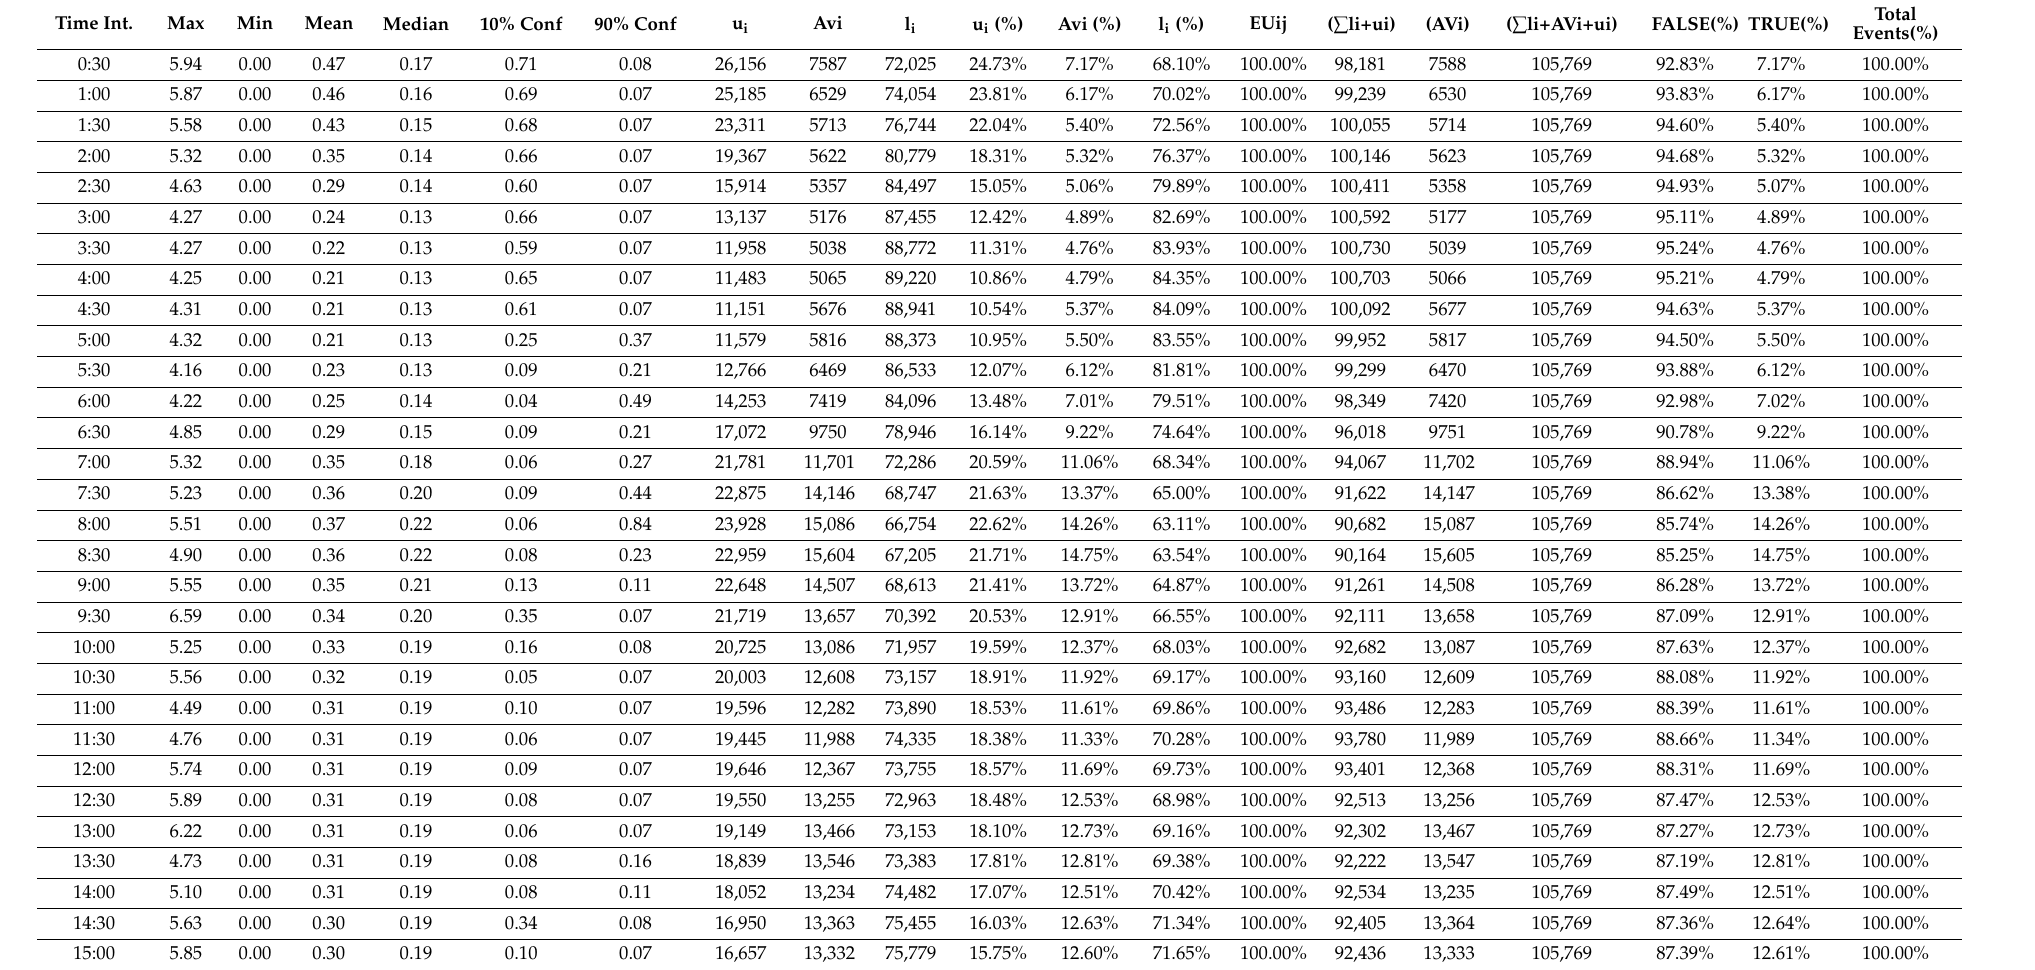
Table 3. Simulation Analysis of True and False Events by